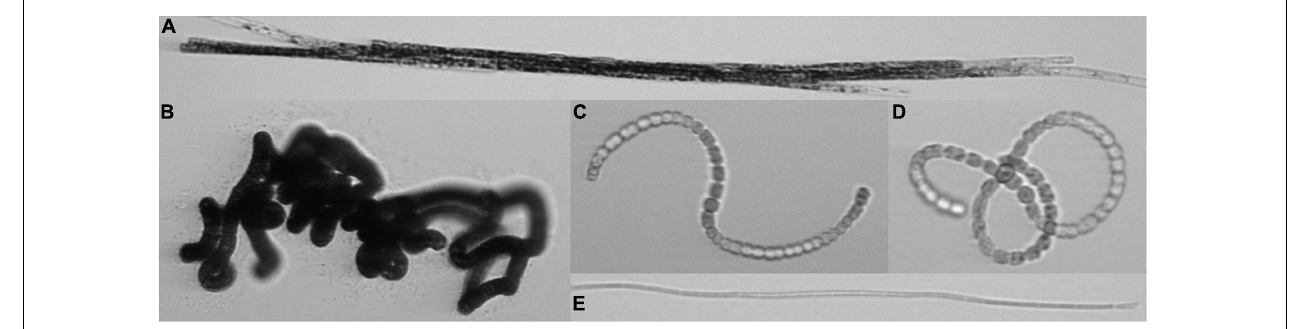
FIGURE 1 | Common filamentous cyanobacteria from the Baltic Sea captured with an Imaging FlowCytobot. Aphanizomenon flosaquae (A) (filament width ca. 5 µ m), Nodularia spumigena (B) (filament width ca. 8–10 µ m), Dolichospermum spp. (C) (representing the group “straight,” i.e., not forming closed loops), (D) (representing the group “coiled,” i.e., forming closed loops) (filament width ca. 5–7 µ m), Oscillatoriales (E) (filament width ca. 1.5–2 µ